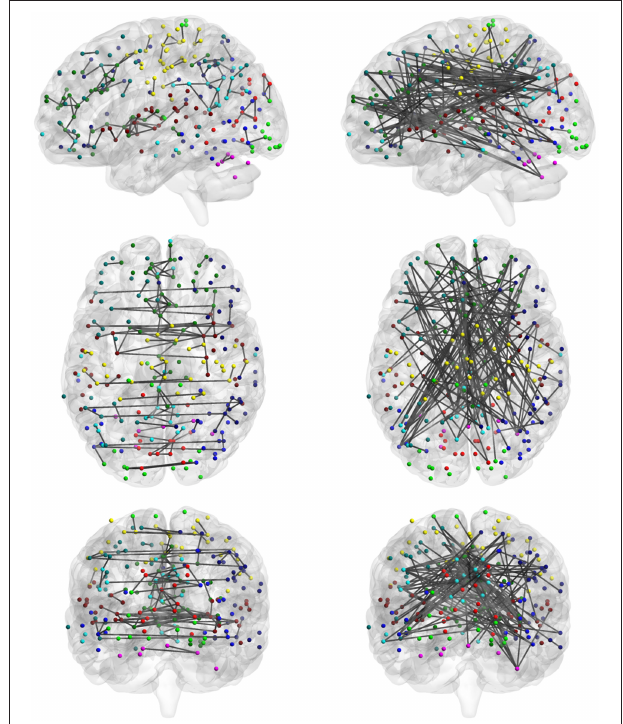
FIGURE 11 | Highly consistent positive and negative edges between partial correlation and full correlation. We selected the top 130 positive edges and top 130 negative edges with an absolute effect size larger than 0.5 in both partial correlation and full correlation. (left: positive; right: